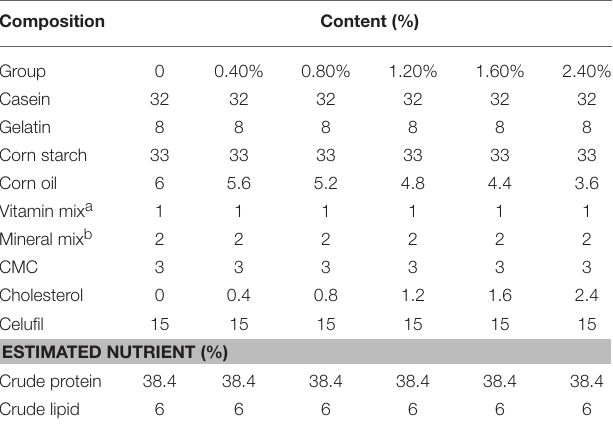
TABLE 1 | Percent composition and estimated nutrient contents of experimental